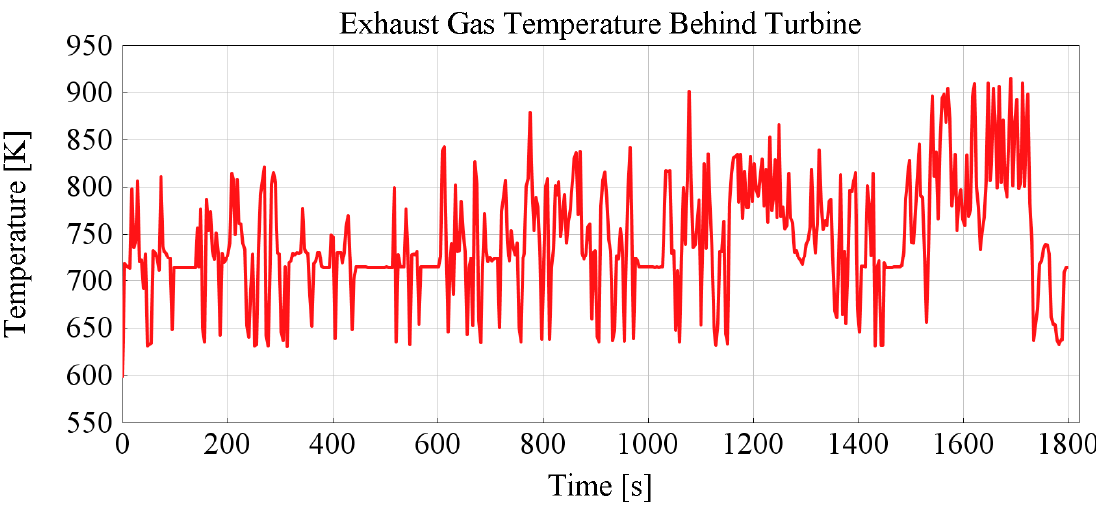
Figure 8. Exhaust gas temperature under WLTC cycle.